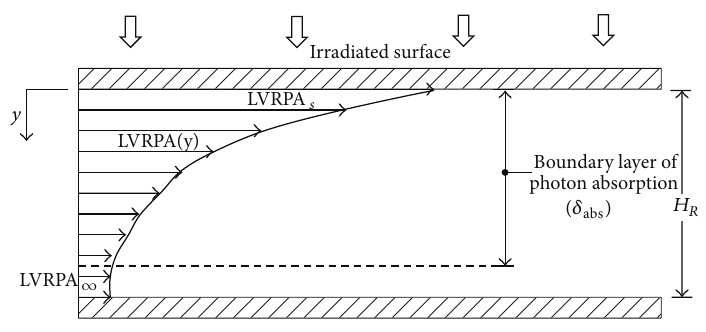
Figure 1: Boundary layer of photon absorption in a double flat plate reactor irradiated onto upper